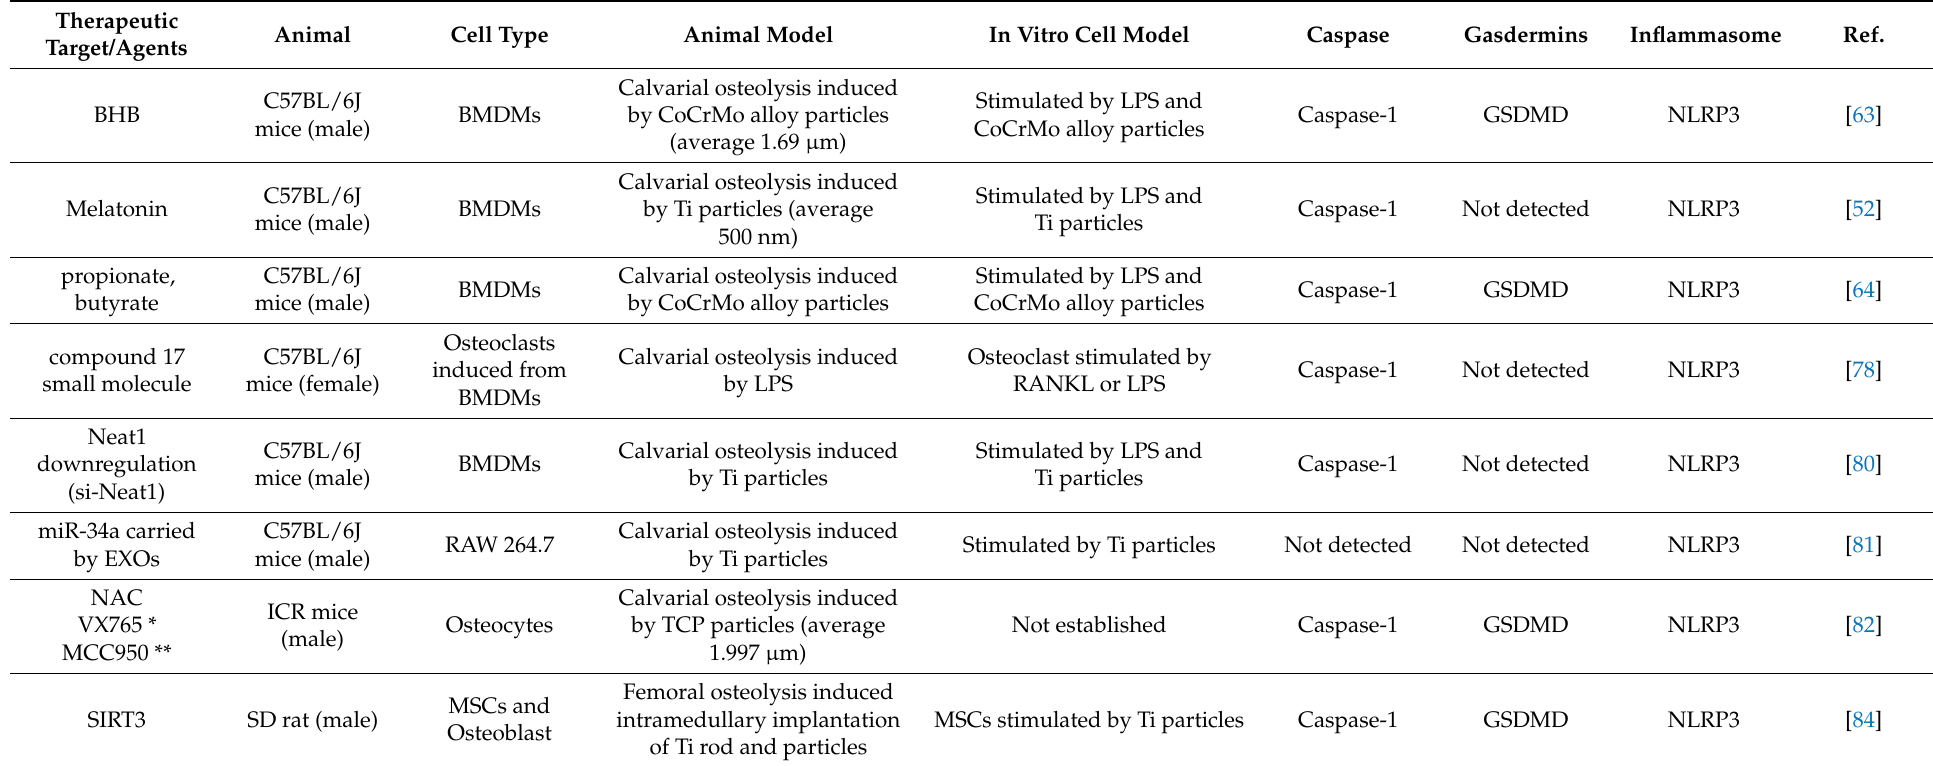
Table 1. Research on inflammasomes and